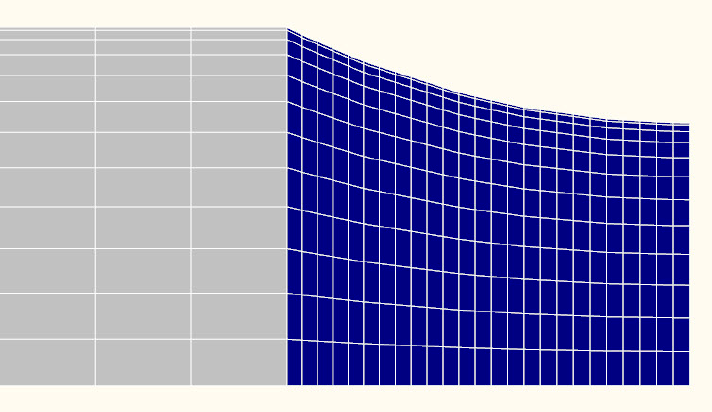
Figure 10. The finite element model of the specimen for dynamic test highlighting the notch area.